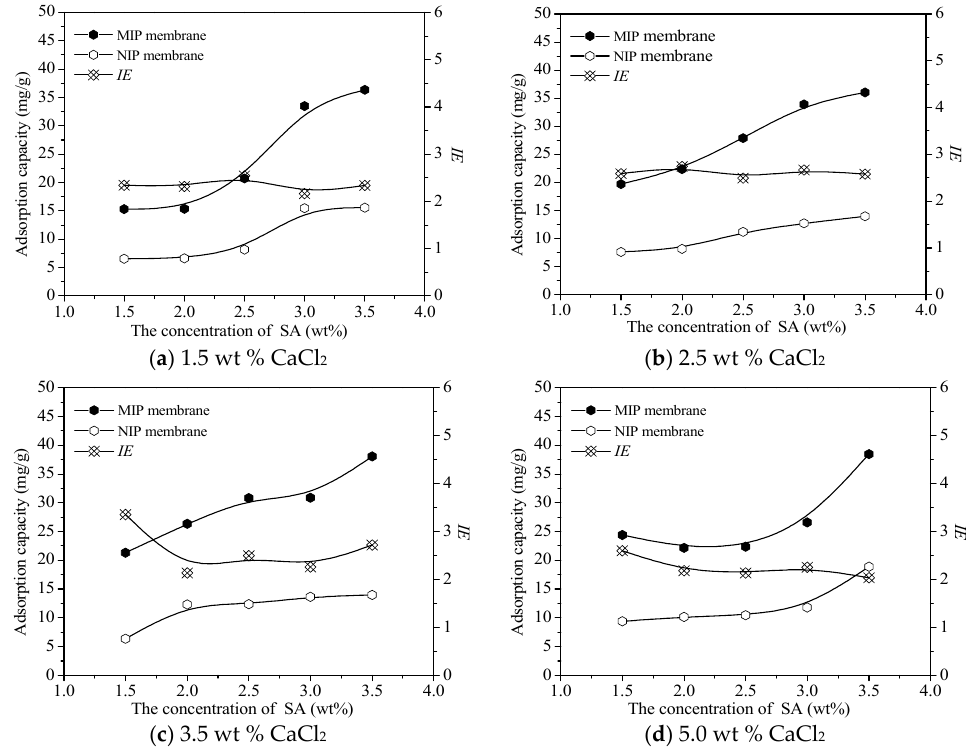
Figure 6. Adsorption capacity and IE of the MIP membrane prepared with different CaCl 2 and SA concentrations.